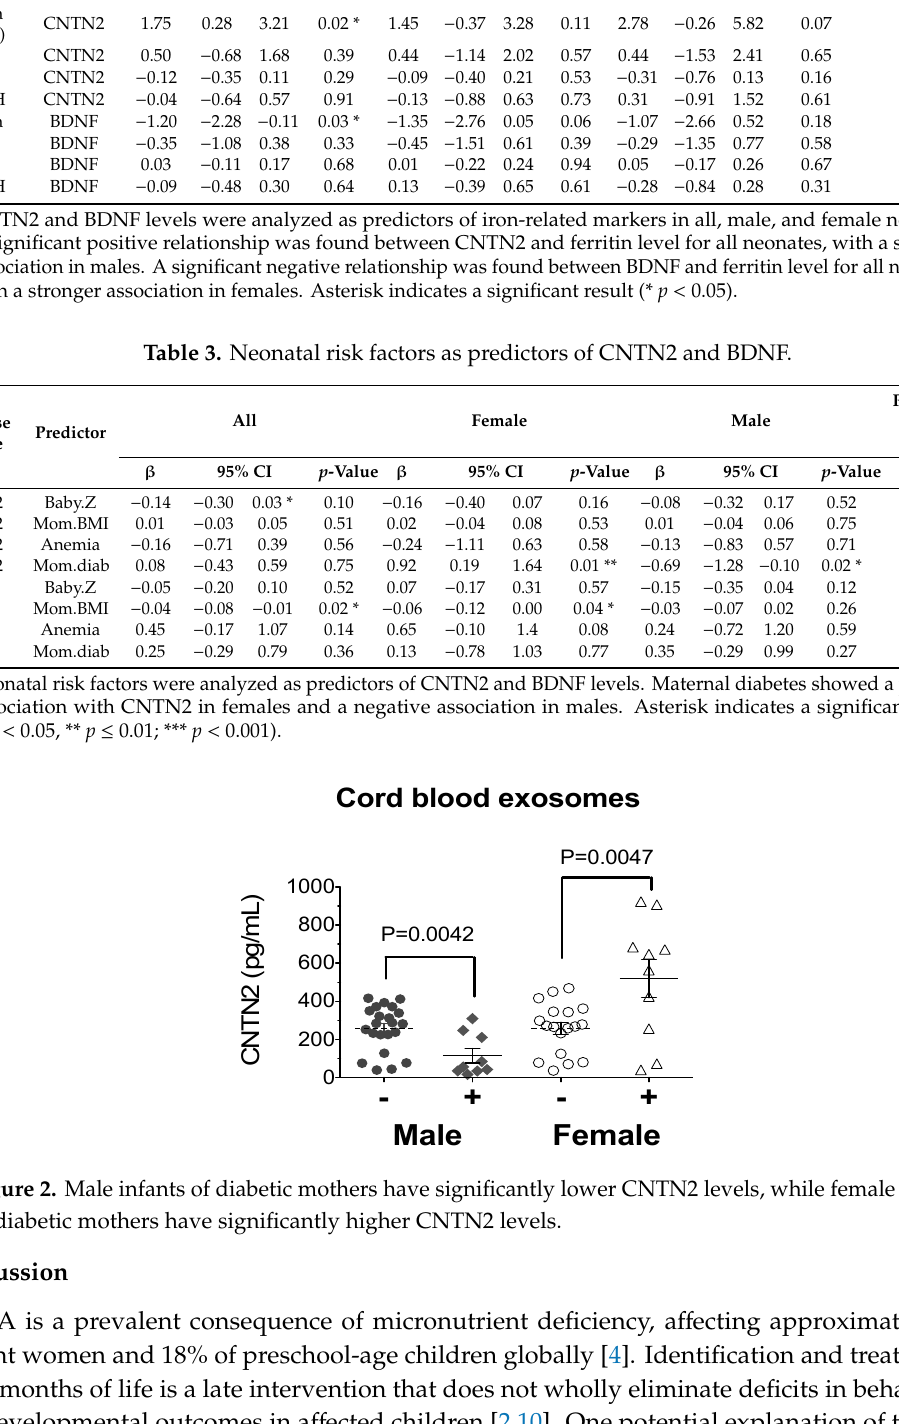
Table 2. Contactin-2 (CNTN2) and brain-derived neurotrophic factor (BDNF) as predictors of iron- related markers.